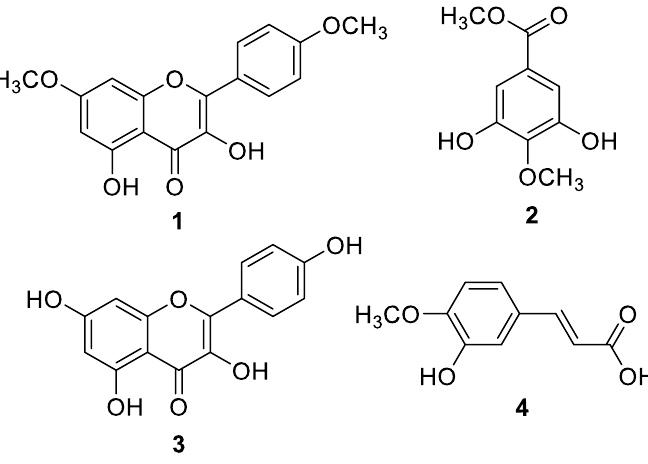
Figure 1. Structures of Compounds 1 - 4 .